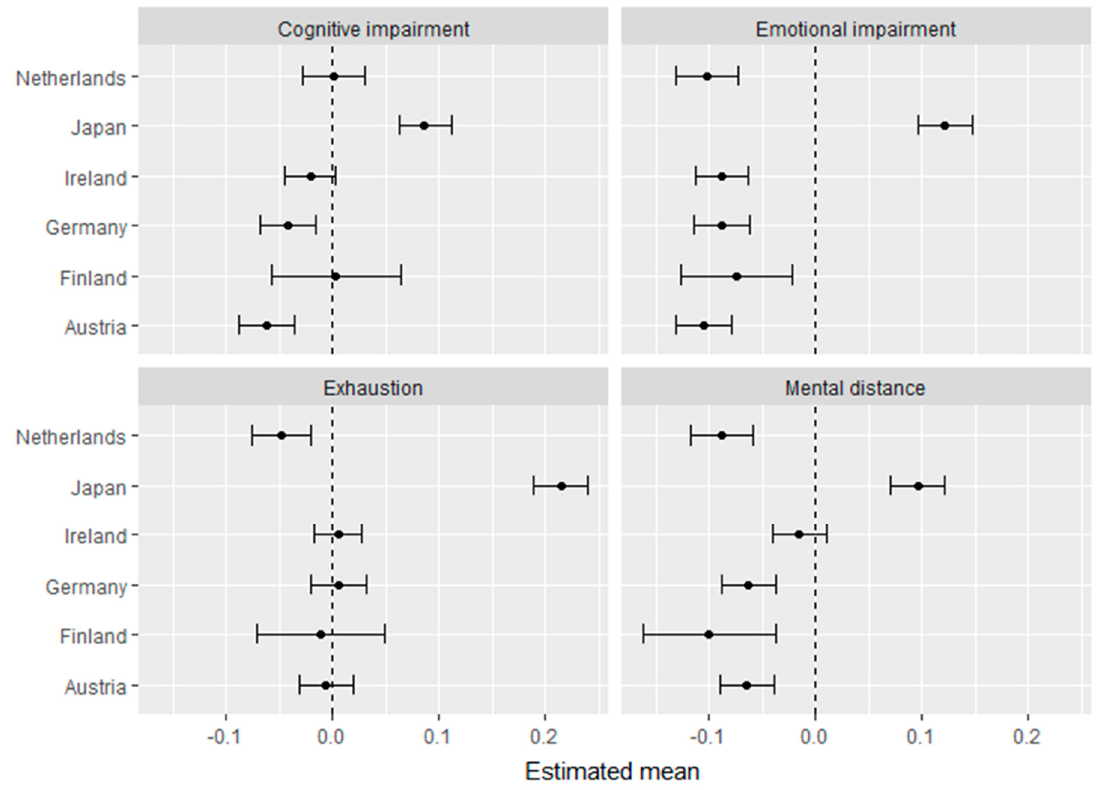
Figure 3. E ff ect sizes with 95% CIs for the first-order burnout component with Belgium as a Figure 3. Effect sizes with 95% CIs for the first-order burnout component with Belgium as a reference reference group.